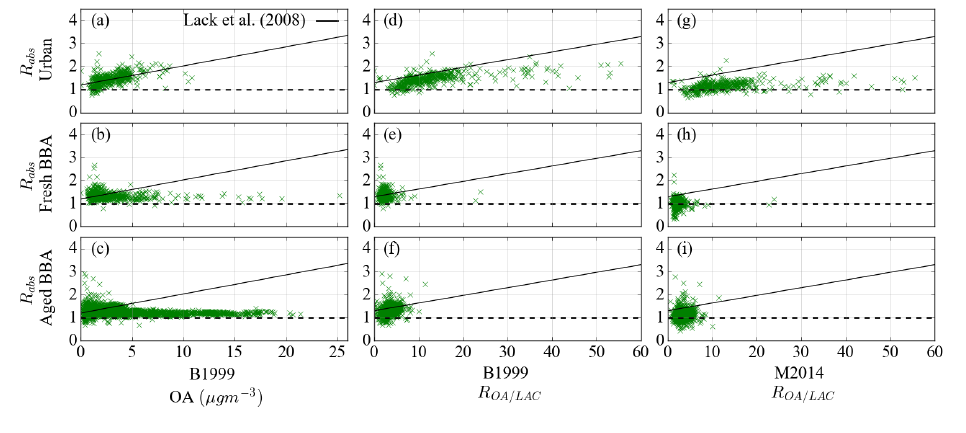
Figure 6. The ratio of TAP to PAS absorption coefficients at 528nm as a function of the organic aerosol mass concentration using the B1999 correction scheme ( a – c ) and as a function of the ratio of the organic aerosol to light-absorbing carbon mass concentrations when using the B1999 correction scheme ( d – f ) and using the M2014 (V2010 parameterisation) correction scheme ( g – i ). All absorption coefficients correspond to >1Mm − 1